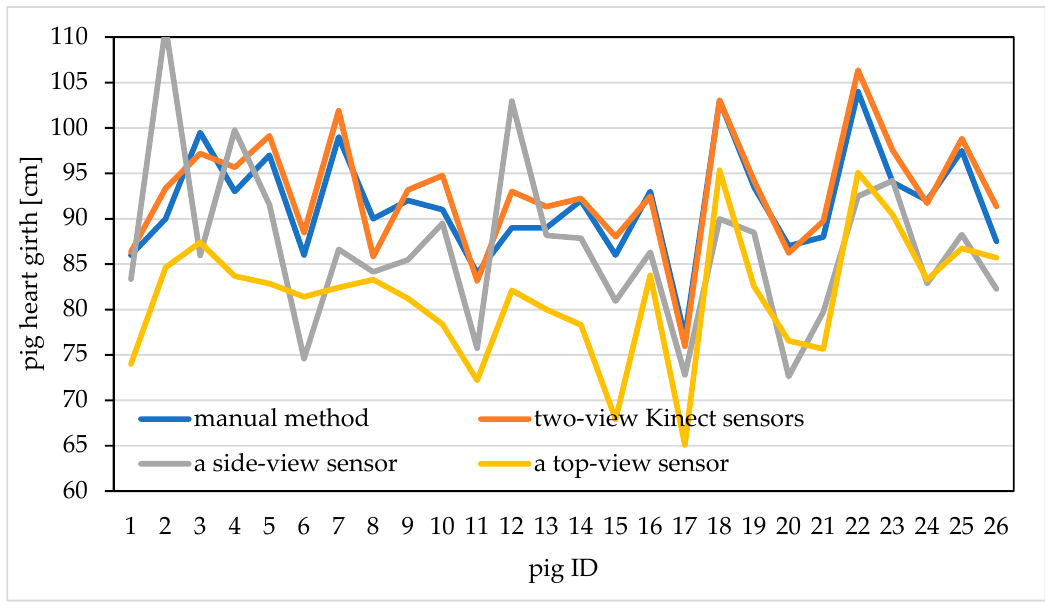
Figure 7 Comparison between the measured value obtain by different data acquisition methods and Figure 7. Comparison between the measured value obtain by di ff erent data acquisition methods and the manual value. the manual